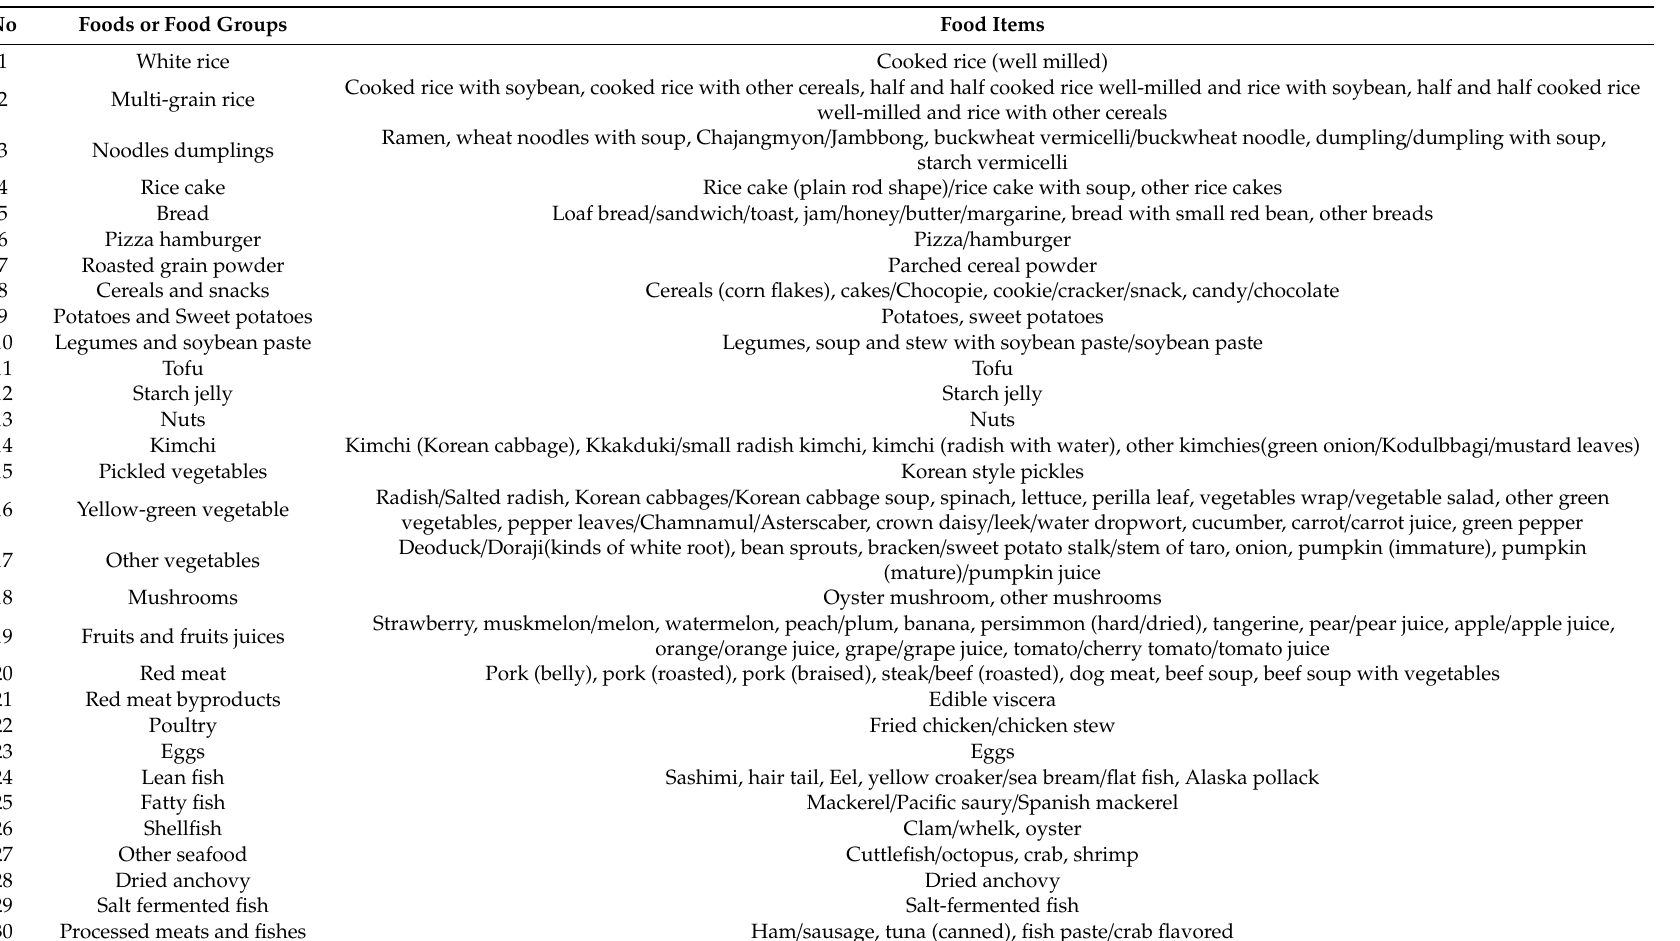
Table 1. Food Groups for Dietary Pattern